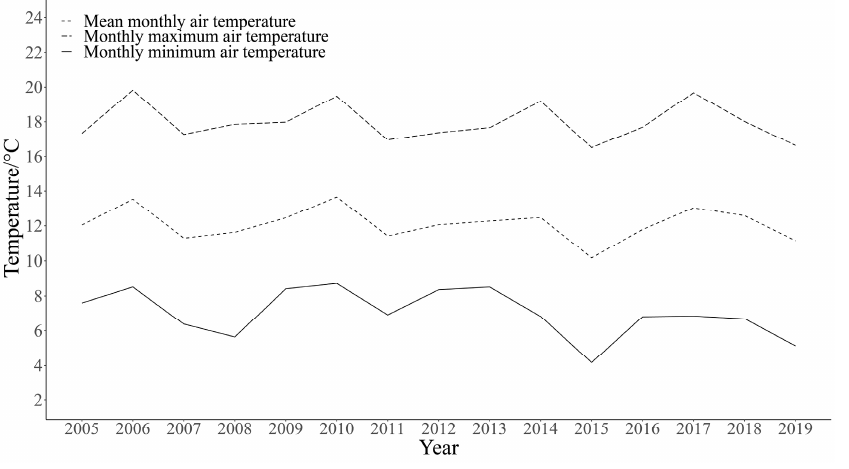
Figure 2. Monthly maximum air temperature, mean monthly air temperature, and monthly mini- mum air temperature in July in Maqu County from 2005 to 2019.